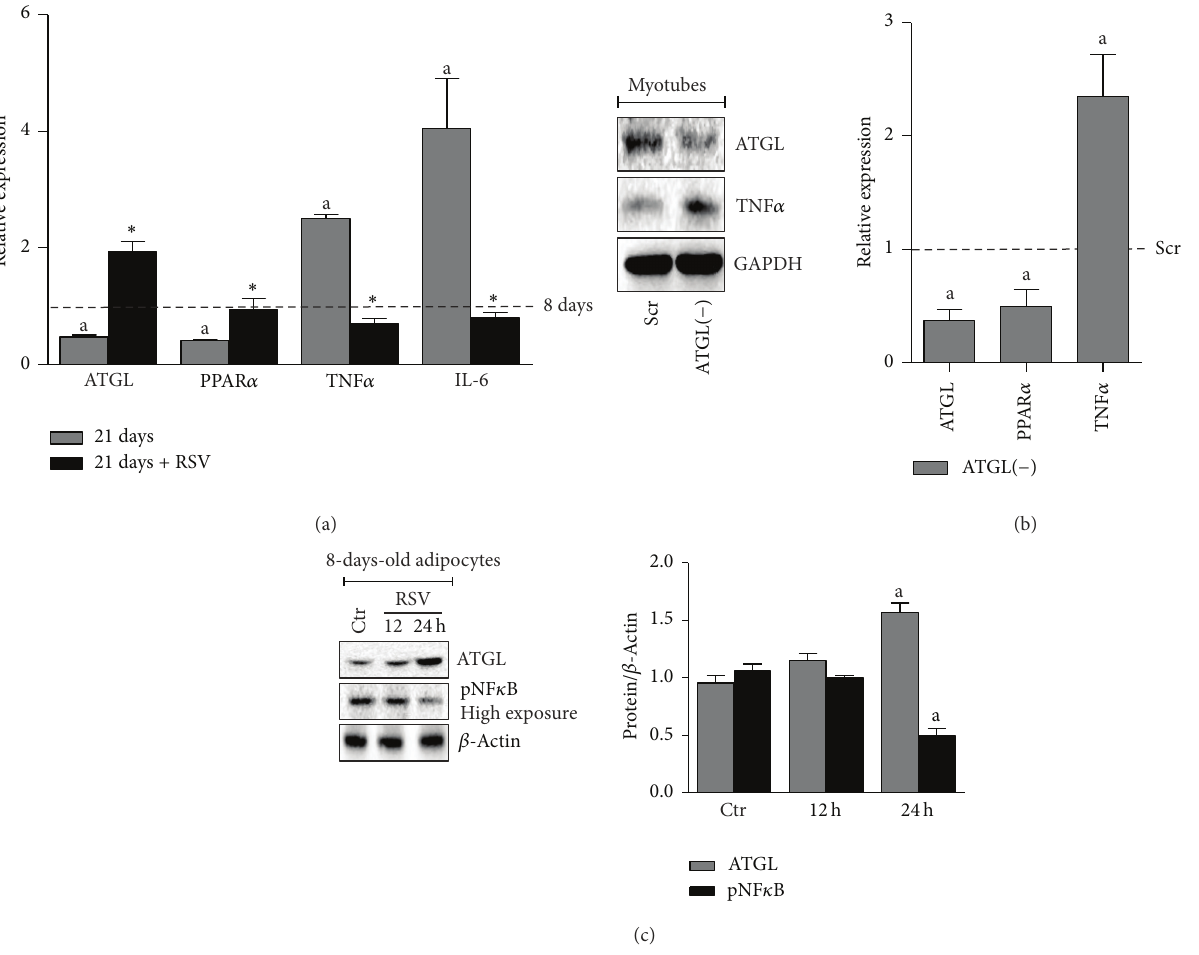
Figure 2: RSV reverts ATGL downregulation and inflammatory markers upregulation in old adipocytes. (a) RT-qPCR analysis of relative ATGL, PPAR 𝛼 , TNF 𝛼 , and IL-6 mRNA levels in 8-day-old (8d) and 21-day-old (21 d) adipocytes. Cells were treated with 100 𝜇 M RSV for 24 h. Values are given as means ± S.D. ( a ) 𝑃 < 0.05 versus 8d; (∗) 𝑃 < 0.01 versus RSV untreated cells. (b) Differentiated C 2 C 12 myotubes (4-days-old) were transfected with siRNA against ATGL [ATGL (−) ] or with a scramble siRNA (Scr). Left panel : western blotting analysis of ATGL, PPAR 𝛼 , and TNF 𝛼 in total protein extracts. Right panel: RT-qPCR analysis of relative ATGL and TNF 𝛼 mRNA levels. Values are given as means ± S.D. ( a ) 𝑃 < 0.05 versus Scr cells. (c) Left panel : western blotting analysis of ATGL and phosphoactive NF 𝜅 B (pNF 𝜅 B) in total protein extracts of 8-day-old adipocytes treated with100 𝜇 M RSV for the indicated times. Right panel : the content of ATGL or pNF 𝜅 B protein was quantified by densitometric analysis. Data are expressed as ATGL/ 𝛽 -actin or NF 𝜅 B/ 𝛽 -actin. Values are given as means ± S.D. ( a ) 𝑃 < 0.05 versus Ctr. GAPDH and 𝛽 -actin were used as loading controls. Data are representative of at least 3 independent